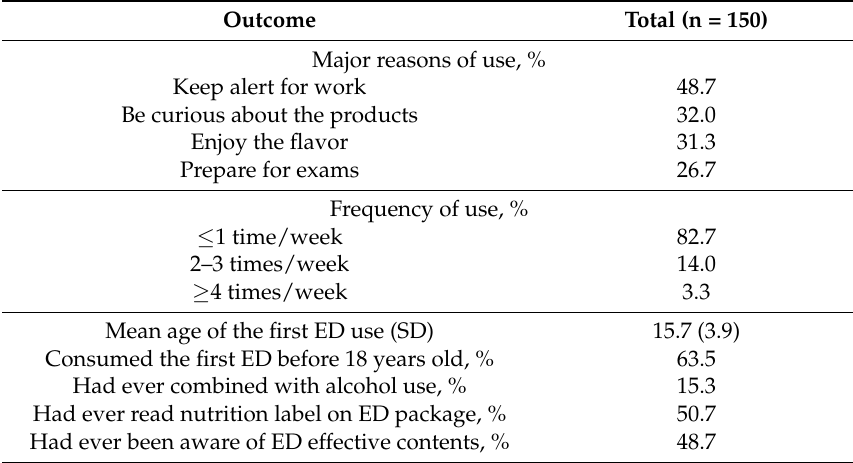
Table 2. Major reasons and patterns of energy drink use in the past 30